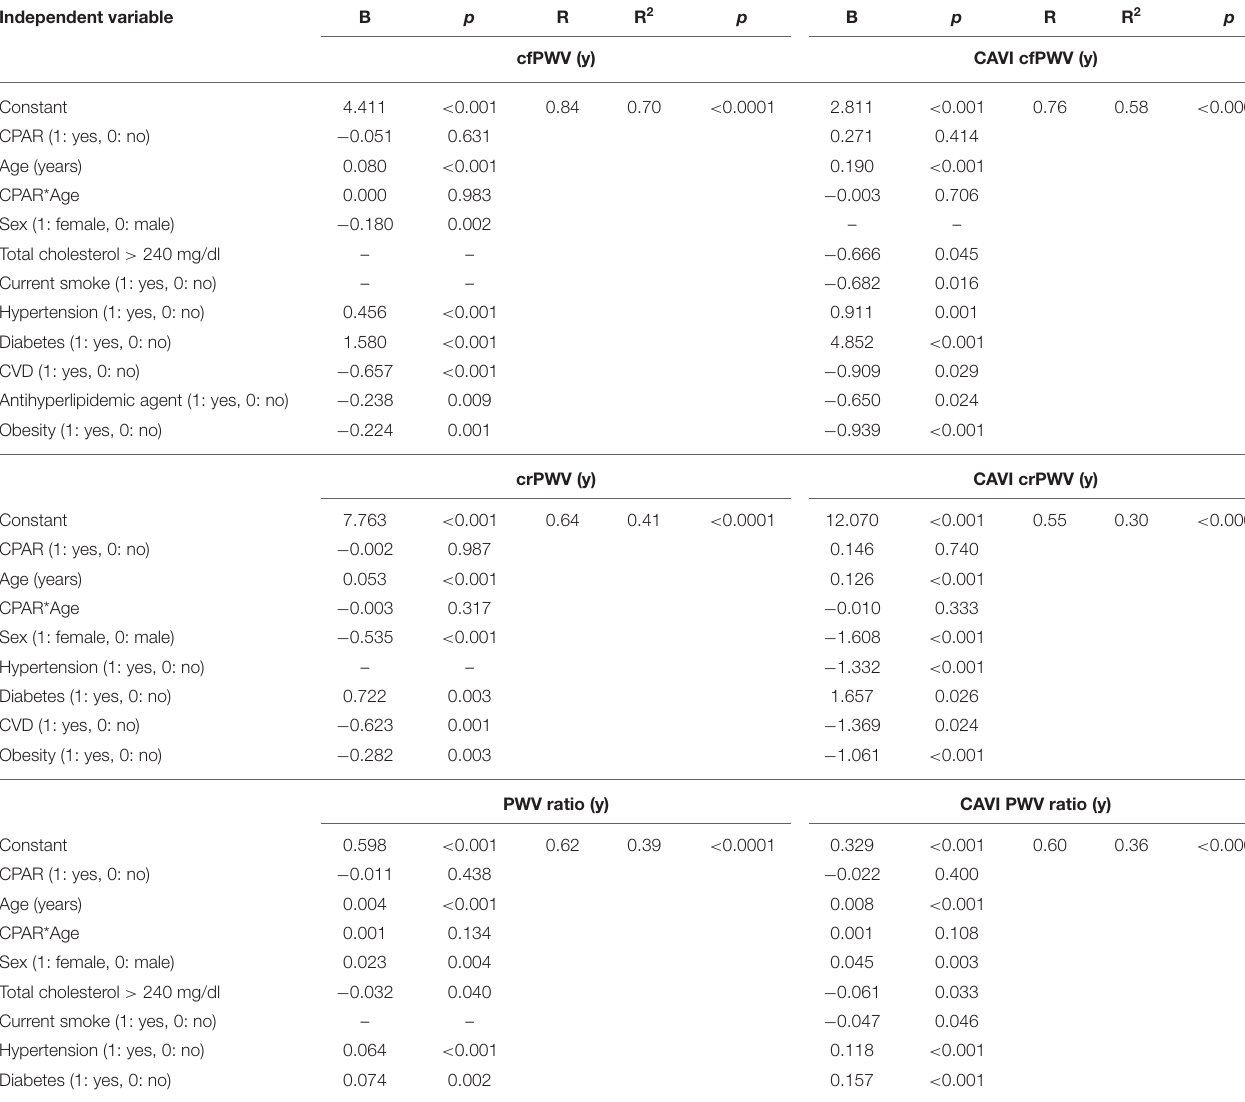
TABLE 6 | Association between CPARs and regional arterial stiffness and stiffness gradient, with age as a moderating variable. Independent variable B p R R